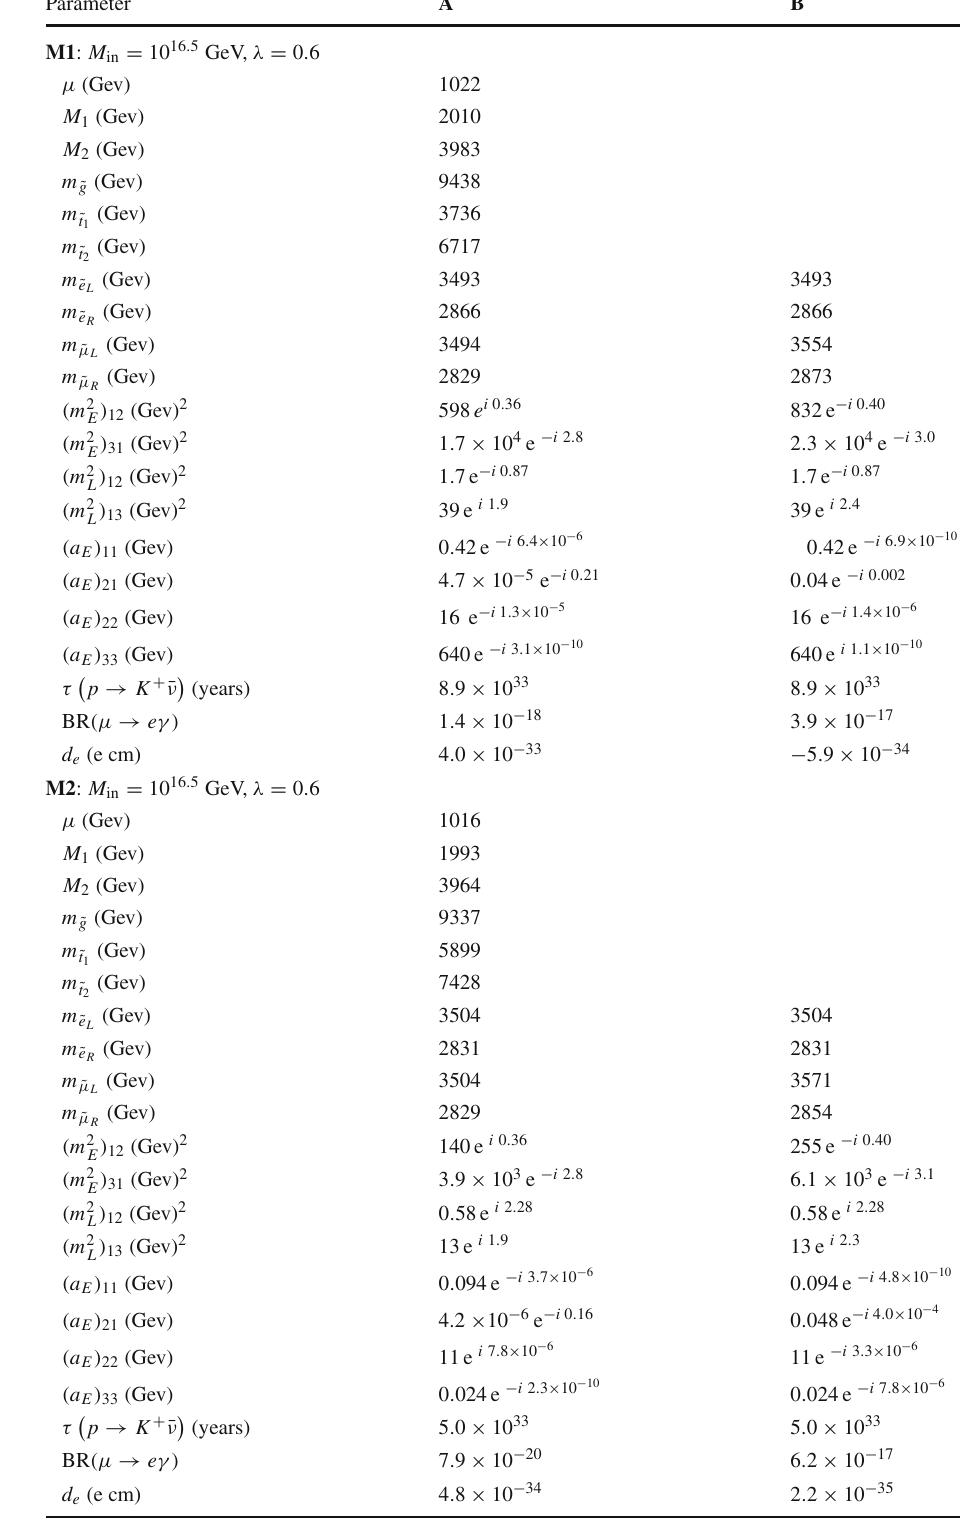
Table 1 Benchmark points in Parameter A models M1 and M2 with m 1 / 2 = 6000 GeV. For M1, m 1 = 9070 GeV, and for M2, m 1 = 5950 GeV. We list values of the parameters relevant for BR (μ → e γ) and the electron EDM obtained with flavor choices A and B , as well as the corresponding predictions for (cid:2) (cid:3) τ , BR (μ → e γ) p → K + ¯ ν and the electron EDM